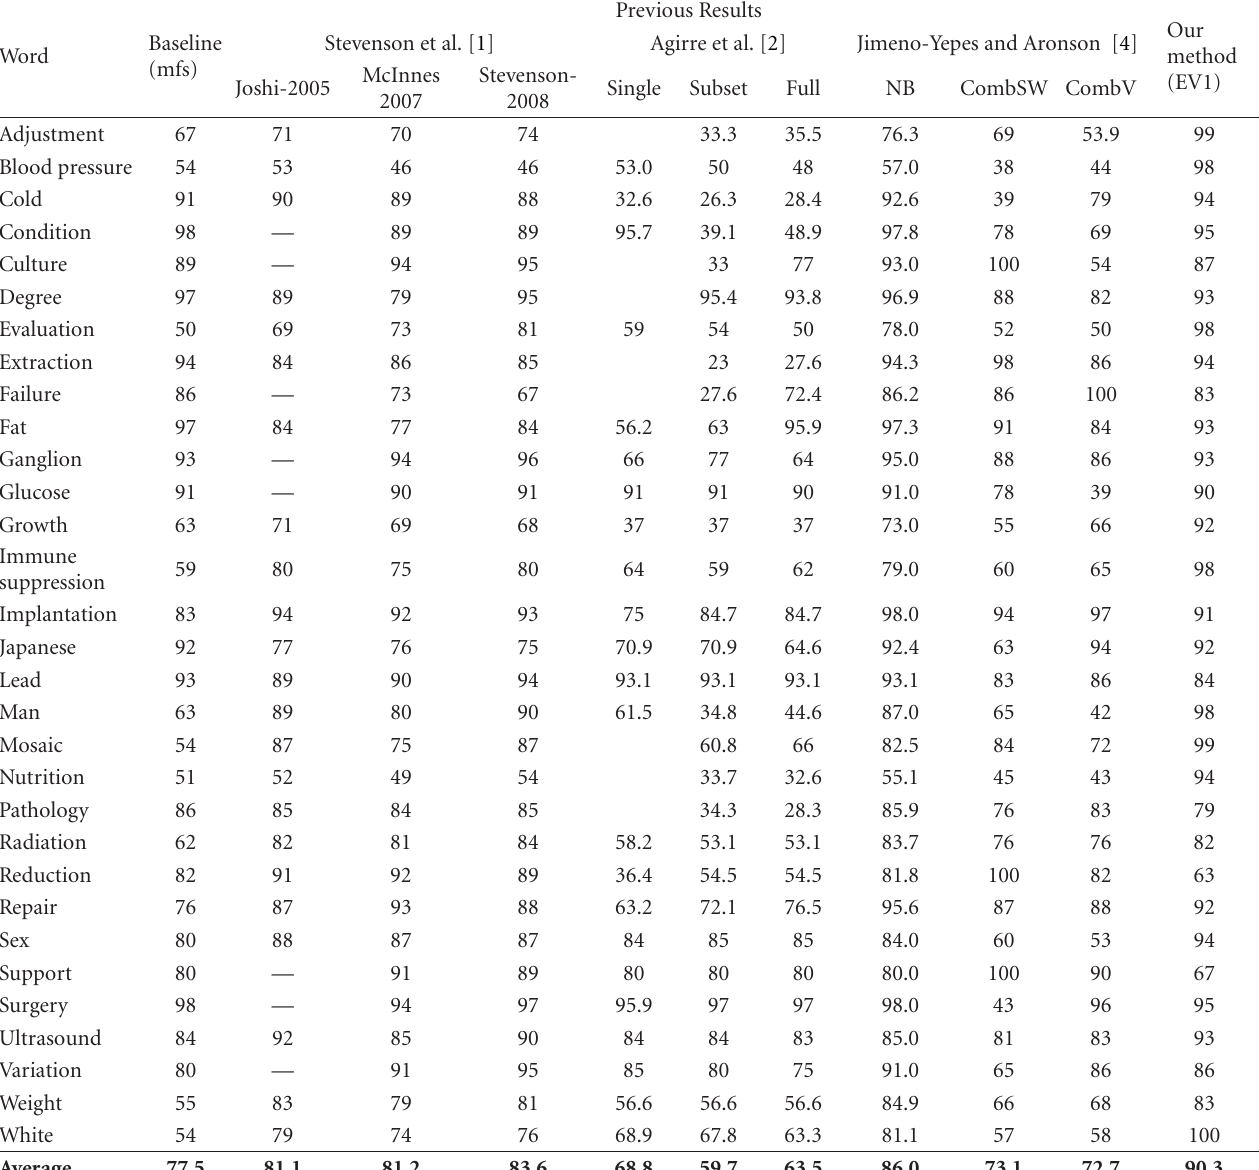
Table 6: Comparison of our results with the best reported results from recent reported